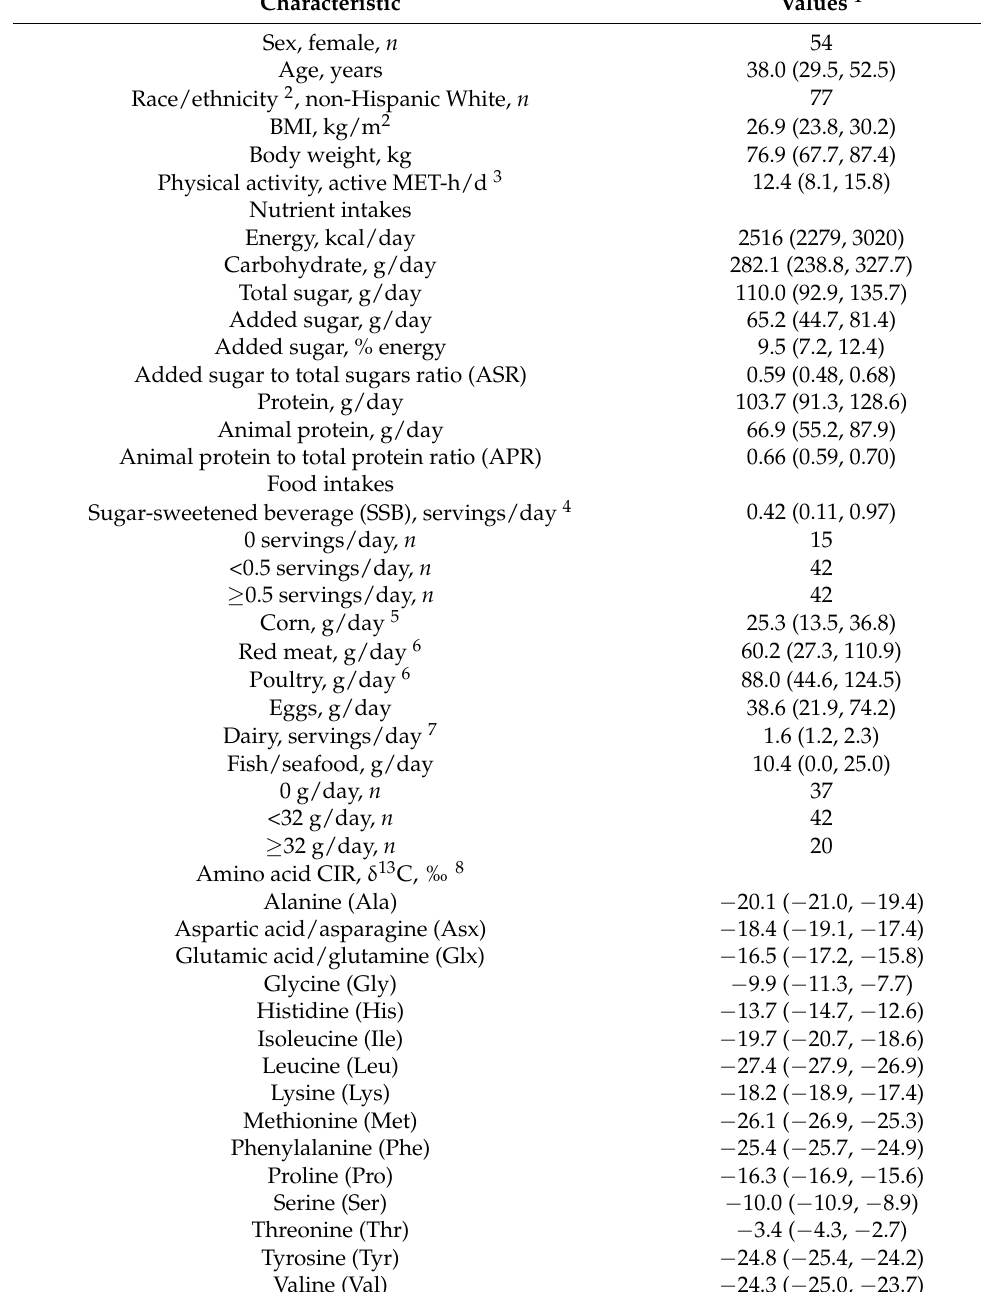
Table 1. Demographic, dietary, and amino acid carbon isotope ratio (CIR AA ) characteristics of study participants ( n =